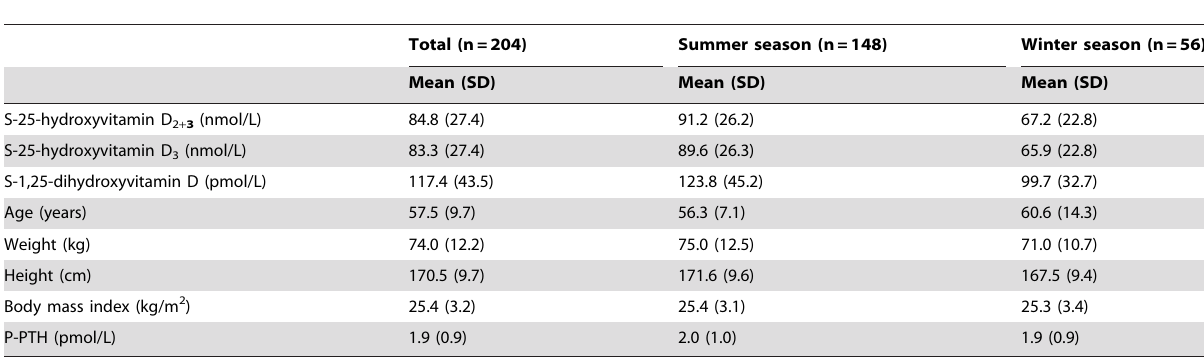
Table 1. Characteristics of the twins as a function of